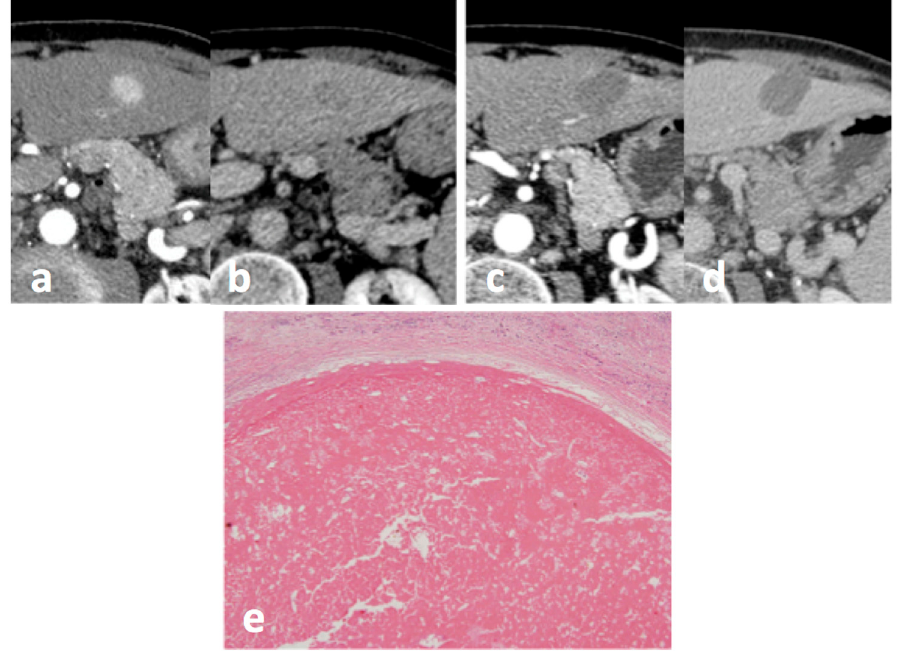
Figure 1. Small HCC in hepatic segment 3 at CT: before treatment, ( a ) arterial phase and ( b ) portal-venous phase, and 1 month after treatment with MW ablation ( c ) arterial phase, and ( d ) portal-venous phase: no enhancing tissue is depicted, and the response was classified as CR according to mRECIST. A complete pathological response was confirmed at pathology: ( e ) HE staining (magnification 10×)